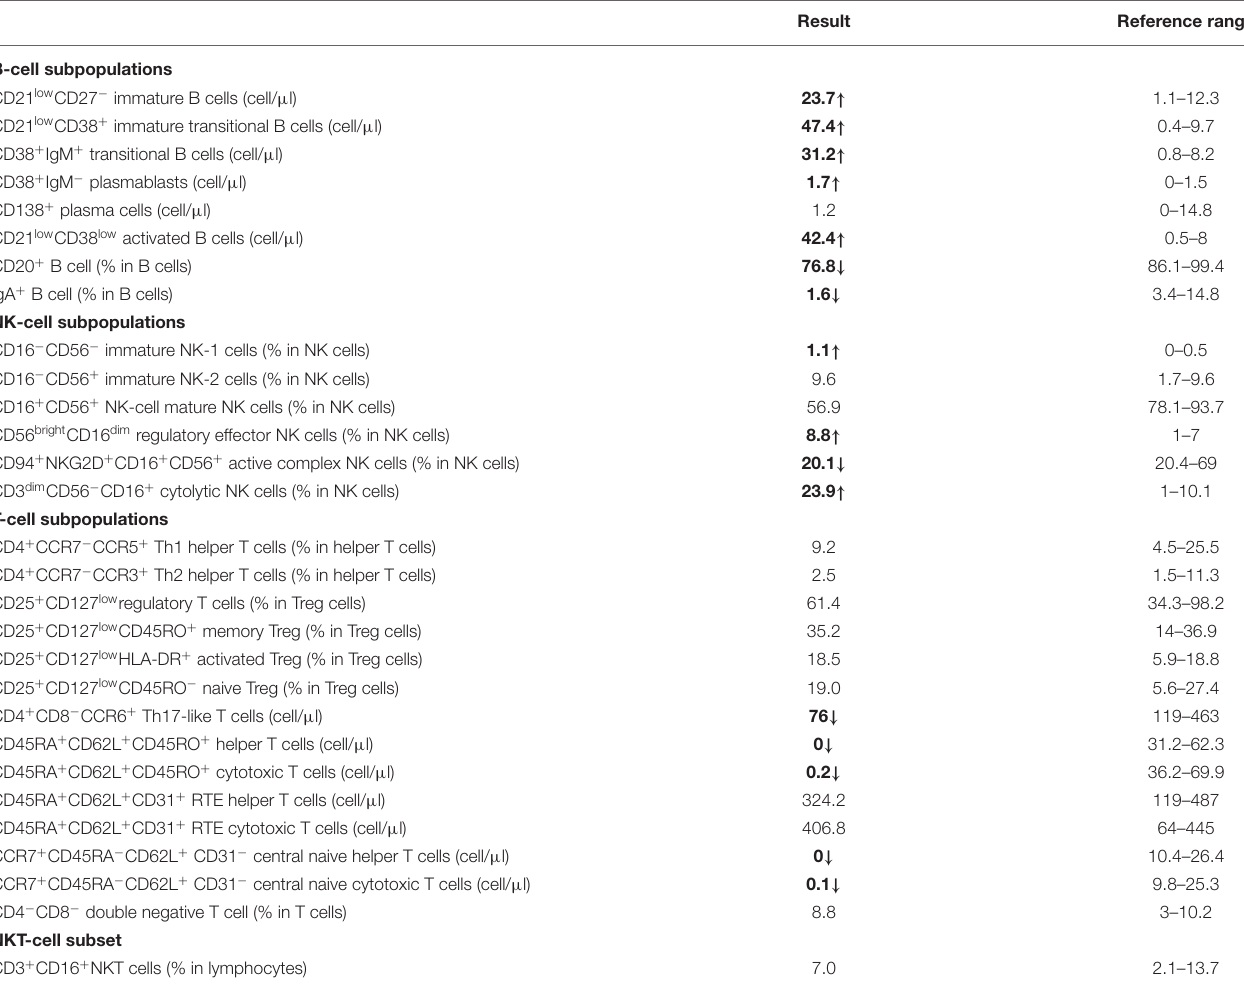
TABLE 1 | Extended B-, T-, and NK-cell subsets within the lymphocytes of the proband with homozygous CD70